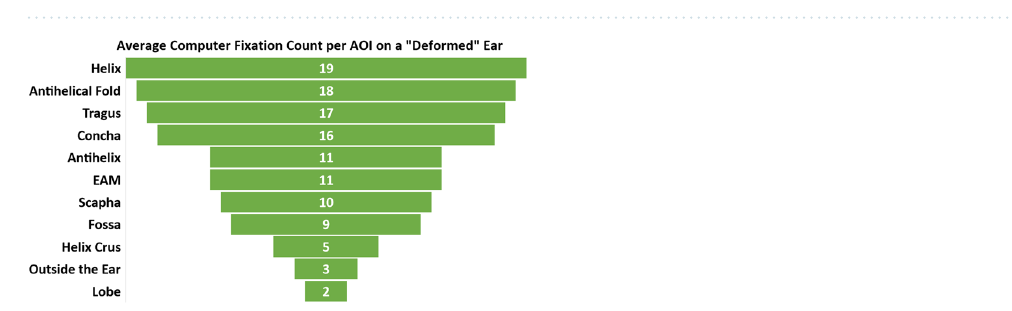
Figure 2. Top row: ears classified as deformed by CNN which are in agreement with the PAs’ evaluations (score < 4). Bottom row: ears classified as deformed by CNN but received good scores from the PAs (≥ 4), exhibiting disagreement.